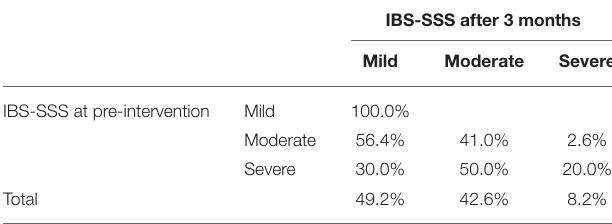
IBS-SSS after 3 months Moderate Severe